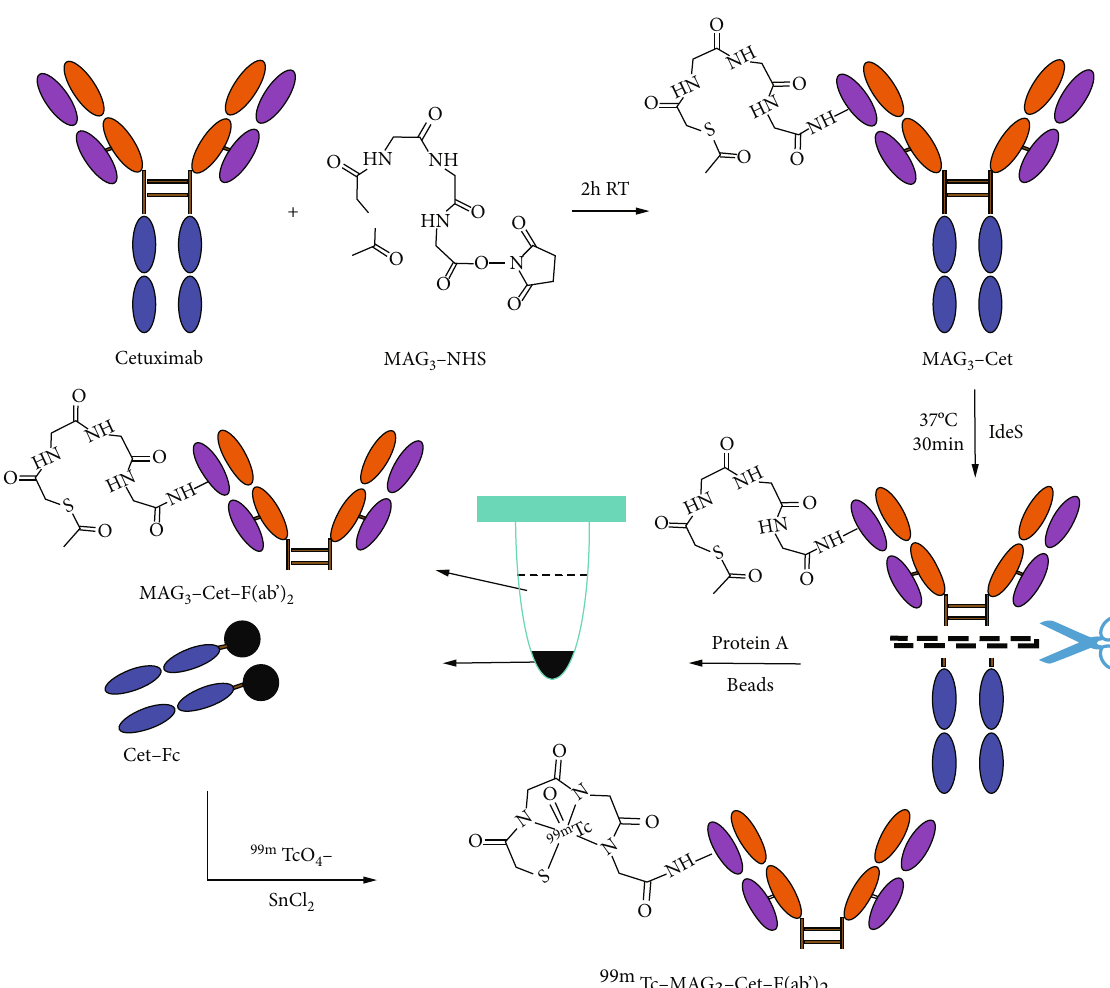
Figure 1: Schematic diagram illustrating the synthesis of 99m Tc-MAG of the radiolabel, and not that only one MAG